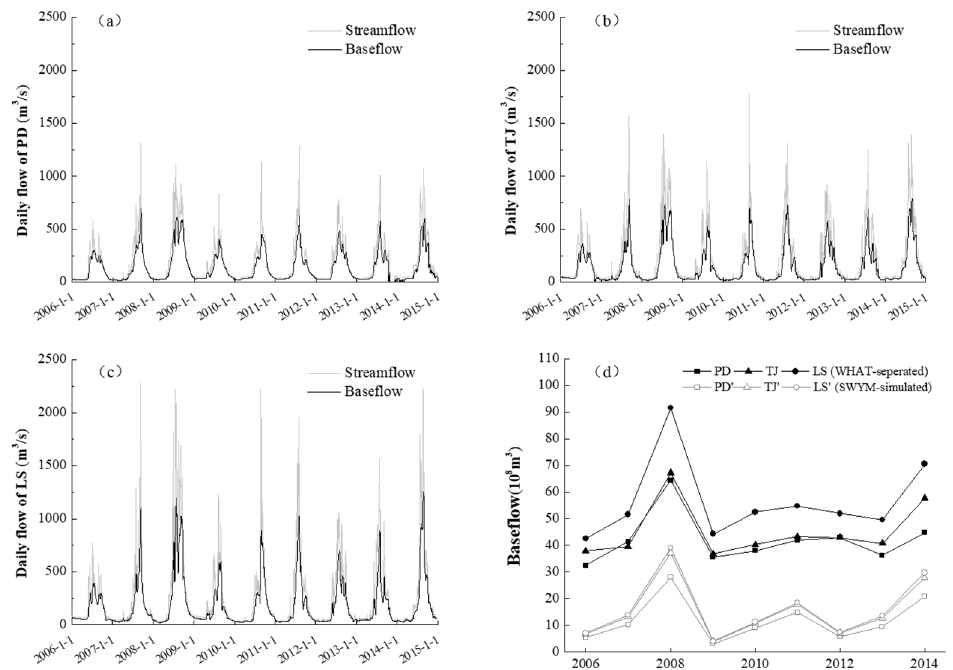
Figure 3. ( a – c ): The observed streamflow and WHAT (Web-Based Hydrograph Analysis Tool)-separated baseflow of the three hydrological stations from 2006–2014: Pangduo (PD), Tangjia (TJ), Lhasa (LS); ( d ) Comparison between the WHAT-separated and SWYM (Seasonal Water Yield Model)-simulated annual baseflow.